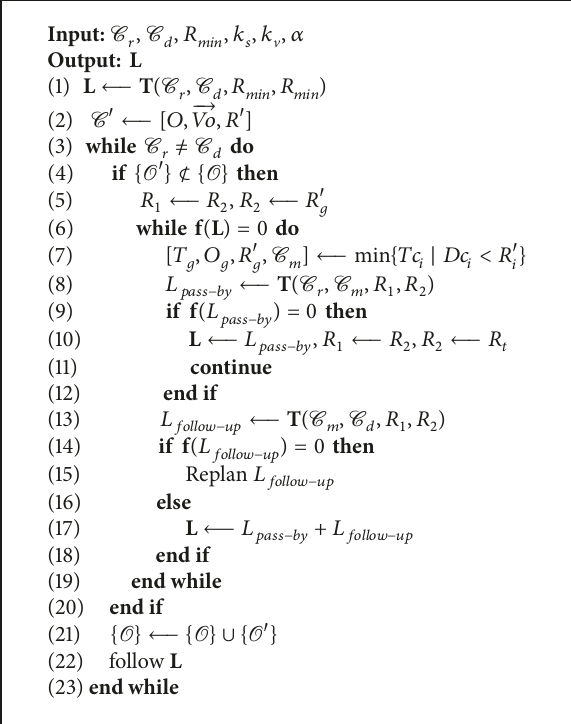
Algorithm 3: The DAPF path planning